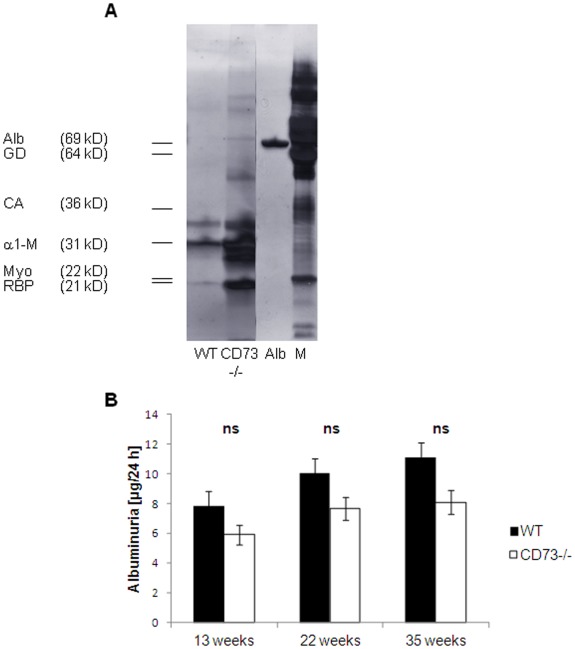
Total proteinuria in CD73−/−mice is a low molecule proteinuria.(A) Profiling the urinary protein content, 10 µg of total urinary protein from WT and CD73−/−mice were subjected per lane to a 12.5% nonreducing SDS-PAGE (silver staining). Mice groups are shown as indicated, Alb  =  bovine serum albumin, M  =  rainbowmolecule weight marker with characteristic proteins as indicated (CA  =  carbonic anhydrase, GD  =  glutamatic dehydrogenase, Myo  =  myoglobin red). Proteins bands identified by size are indicated: α1-M  =  α 1-microglobulin, RBP  =  retinol binding protein. (B) Urinary albumin excretion was not different as compared to WT mice. 9 to 24 mice per group were used. Data are presented as means SEM.